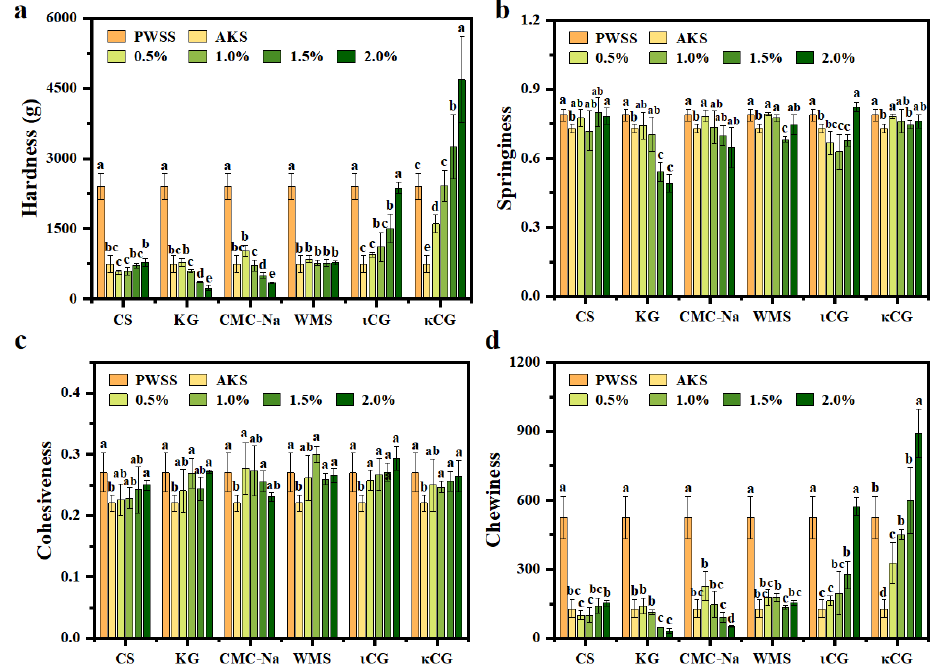
Figure 8. Texture properties of shrimp surimi gels: ( a ) Hardness, ( b ) springiness, ( c ) cohesiveness, and ( d ) chewiness. PWSS, Pacific white shrimp surimi; and AKS, Antarctic krill surimi; CS, chitosan; KG, konjac glucomannan; CMC-Na, sodium carboxyl methyl cellulose; WMS, waxy maize starch; ι CG, ι -carrageenan; and κ CG, κ -carrageenan. Different letters within the same polysaccharide used indicate significant differences ( p < 0.05).